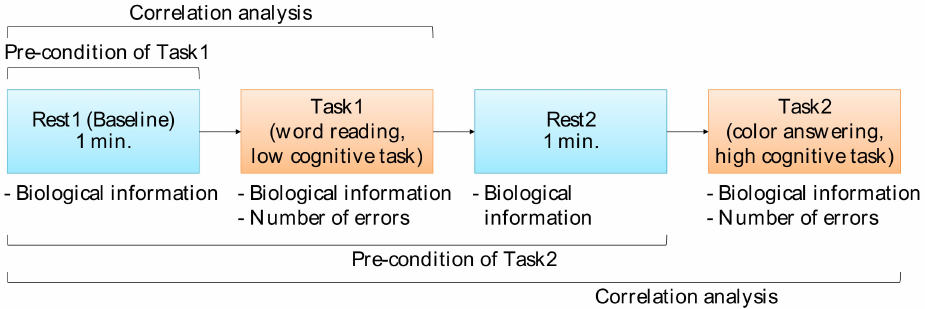
Figure 3. Order of rest and task phases and their relations for correlation